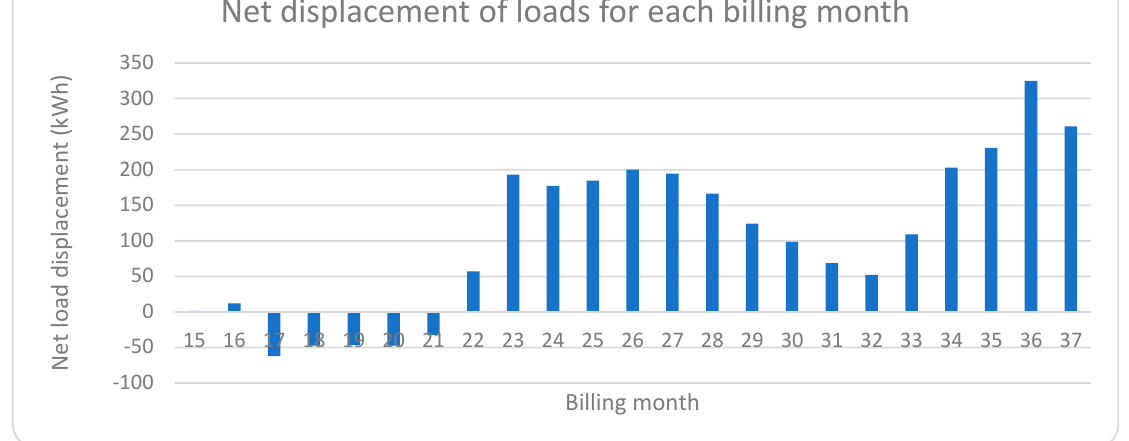
Figure 20. Net load shifting (kWh) per billing month. A positive net balance is obtained from billing 22 due to the performance of the HERMES system.